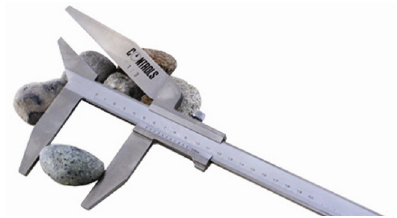
Fig. 3. Shape measuring calliper